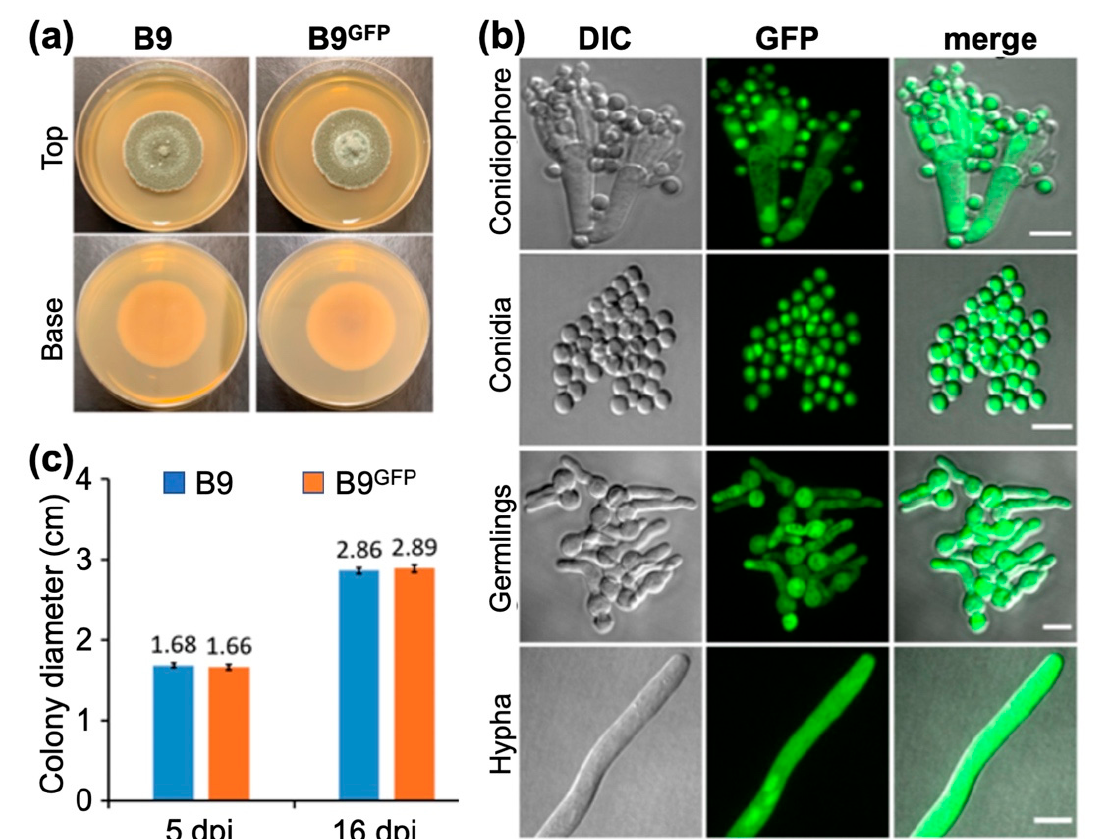
Figure 4. Generation and comparative analysis of the cytosolic GFP-expressing P. citrinum isolate B9. ( a ) Colony morphology and growth characteristics of the P. citrinum B9 and B9 GFP strain. Photographs were taken at 5 dpi ( b ) Confocal microscopy-based confirmation of cytosolic GFP expression in the B9 GFP strain at the indicated stages of fungal development. Scale bar equals 5 µm. ( c ) Cytosolic GFP expression does not affect mycelial growth and asexual development or conidiation in the P. citrinum B9 GFP strain. Conidiation was assessed at day 5 post inoculation, as was growth under constant illumination.